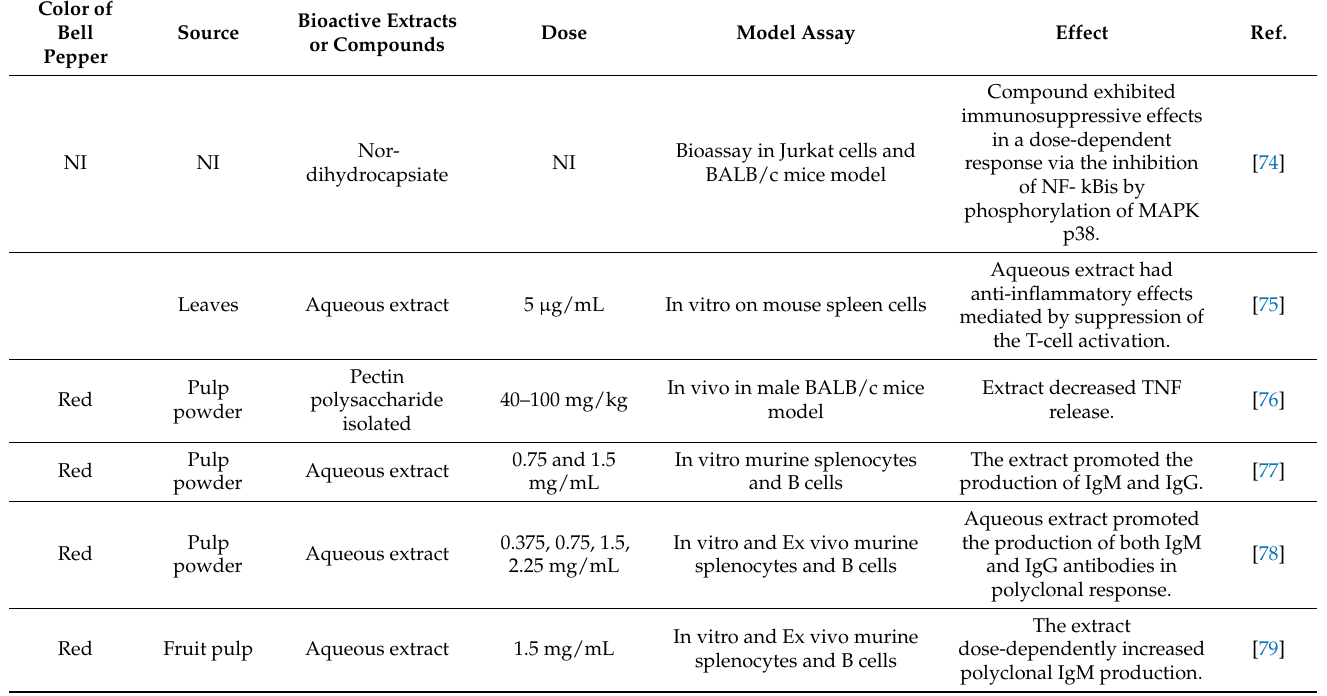
Table 6. Immunomodulatory effects of bell pepper